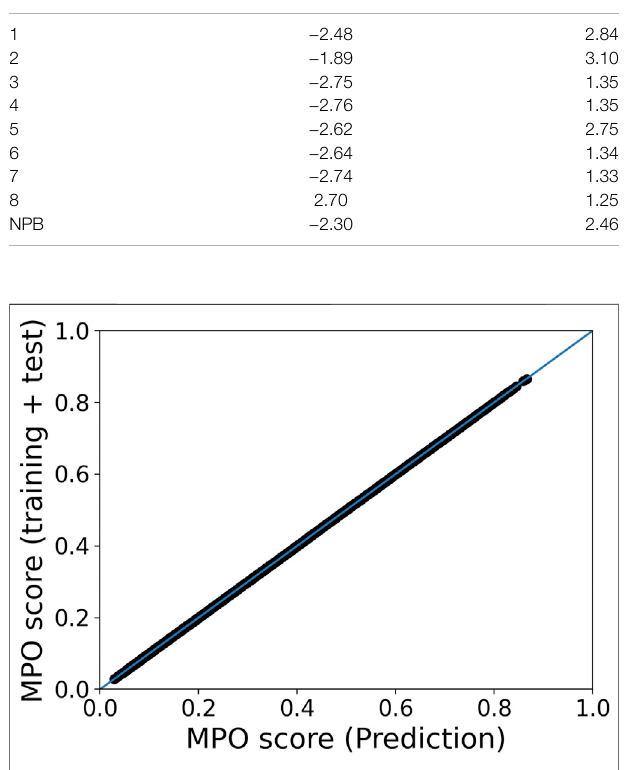
FIGURE 5 | Linear correlation of MPO scores of materials in the HTL dataset obtained during the training of the ML model in the framework of AL and the scores estimated by using the ML model thus generated for the same